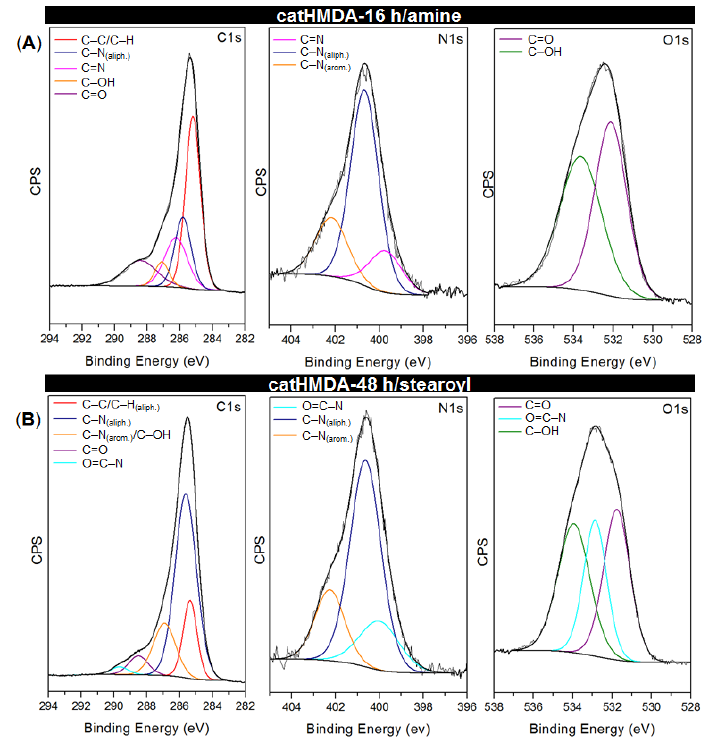
Figure 8. Curve ‐ fitting results corresponding to C1s, N1s and O1s high ‐ resolution XPS spectra for ( A ) Figure 8. Curve-fitting results corresponding to C1s, N1s and O1s high-resolution XPS spectra for ( A ) catHMDA ‐ 16 h/amine and ( B ) catHMDA ‐ 48 h/stearoyl. catHMDA-16 h/amine and ( B ) catHMDA-48